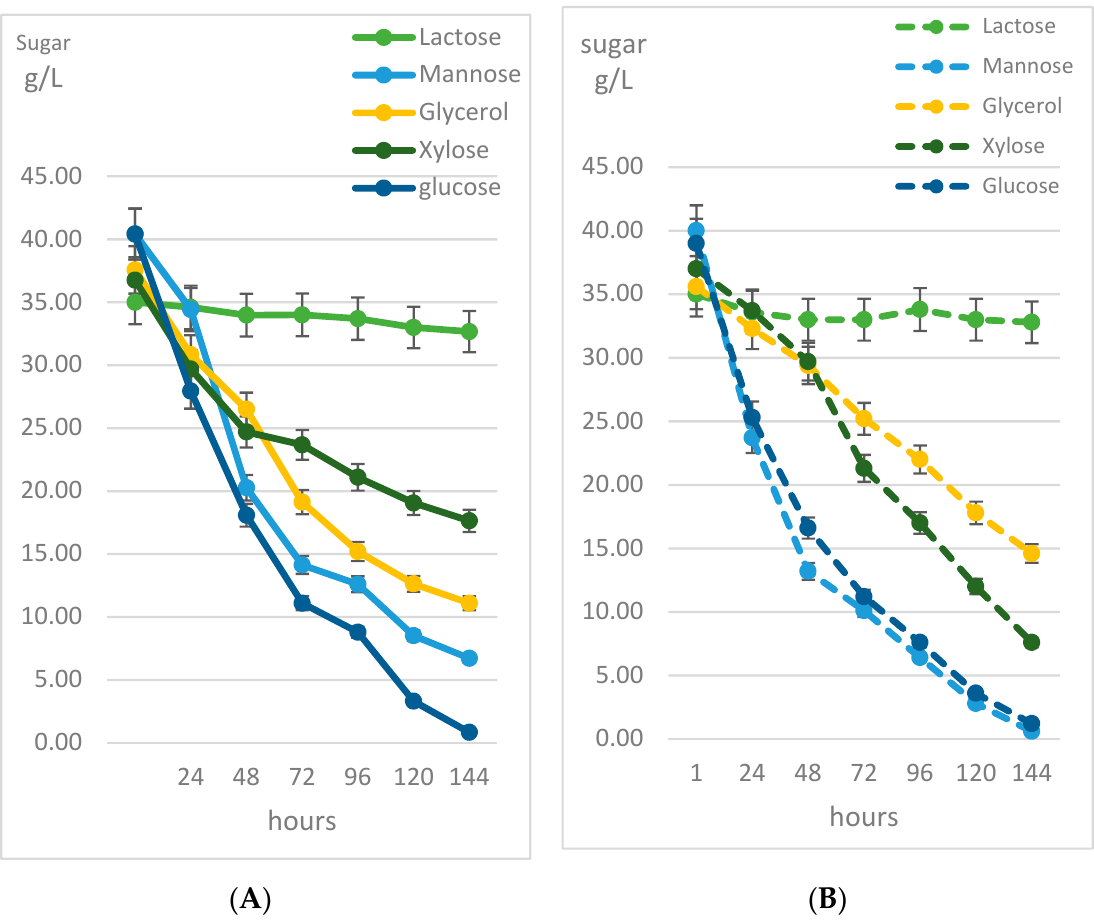
Figure 3. Consumption of different carbon sources by R. kratochvilovae CCY 20-2-26. ( A ) Changes of the concentration of individual sugars in the medium with urea as an N source. ( B ) Changes of the concentration of individual sugars throughout the cultivation in the medium with potassium nitrate as an N